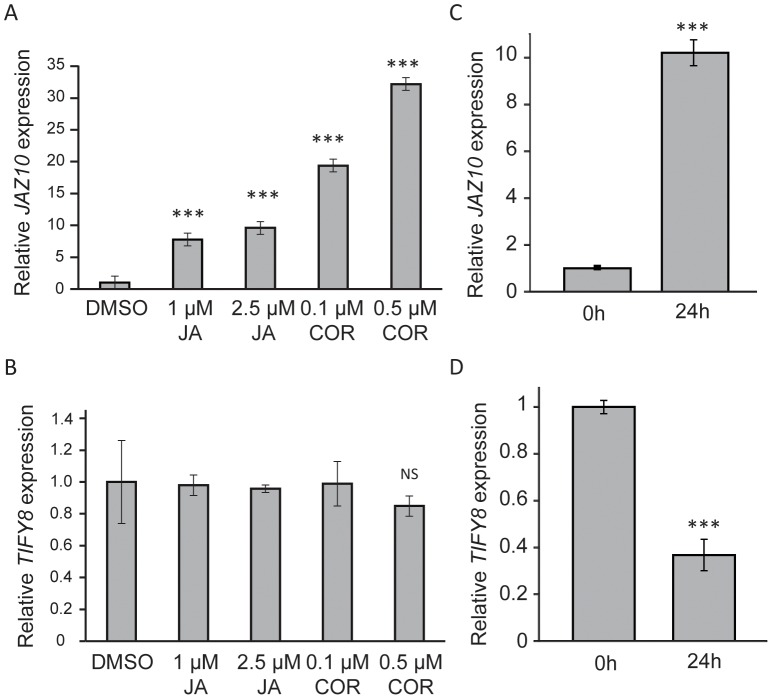

TIFY8 is not induced by JA and is repressed by Pst DC3000 infection.
A–B, RT-PCR analysis of JAZ10 (A) TIFY8 (B) expression after JA treatment. Arabidopsis wild-type seeds were germinated on MS media and, after 8 days, transferred to liquid MS media supplied with different concentrations of JA or COR or equivalent amounts of DMSO (mock treatment). Transcript levels were studied 24 h after treatment. Error bars represent ±SE of four biological replicates. C–D, JAZ10 and TIFY8 expression after infection with Pst DC3000. Transcript levels were studied in 5-week-old Arabidopsis rosette leaves prior to or 24 h after inoculation with Pst DC3000. Error bars represent ±SE of three biological replicates. UBC (AT5G25760) was used as internal control and expression values were normalized to those of the wild-type after mock treatment. (NS, p>0.05; ***, p<0.001, t-test).